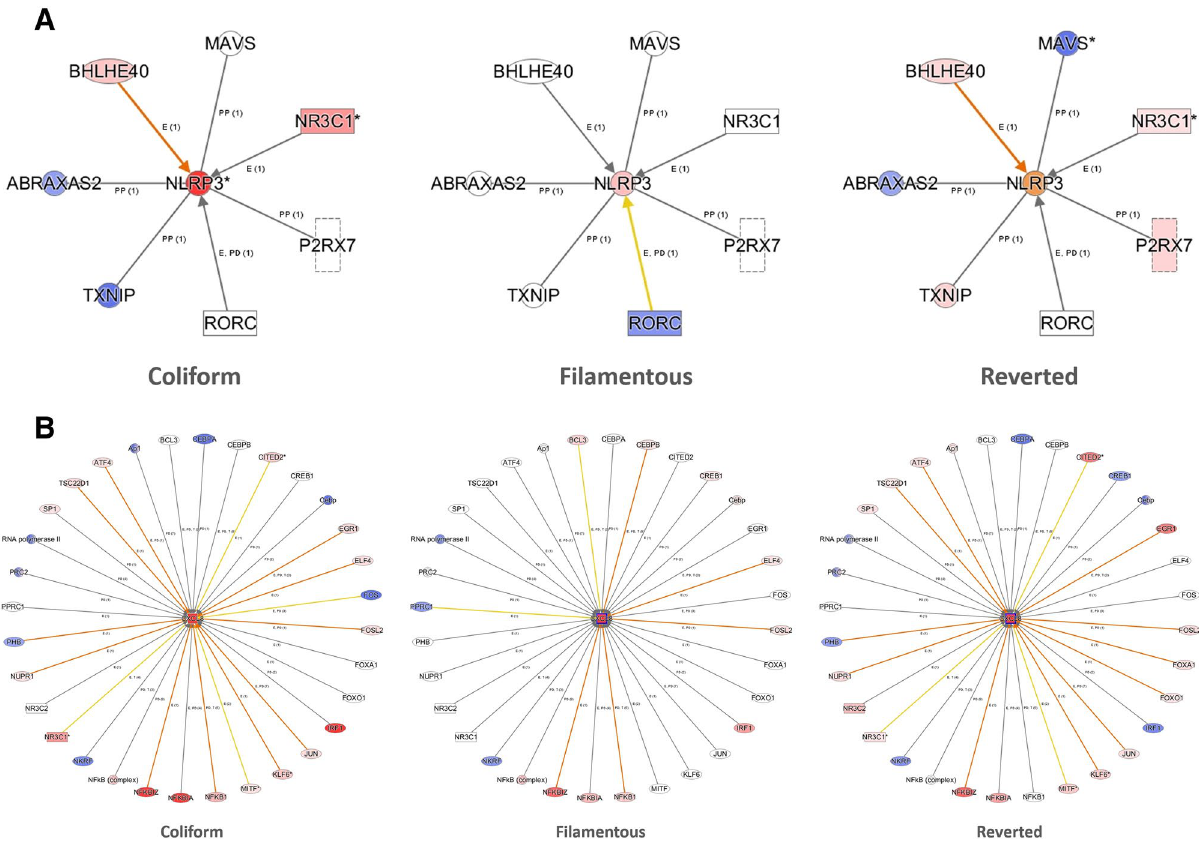
Figure 4. Pathway analysis showing upstream regulators associated with gene expression of ( A ) NLRP3 and ( B ) CXCL8. Red regulators are upregulated compared to unstimulated control cells while blue are downregulated. Red/orange lines indicate that the regulator leads to a predicted activation of gene expression while yellow lines indicate disagreement between the state of the upstream regulator and the predicted function. Grey lines indicate that no activation pattern can be